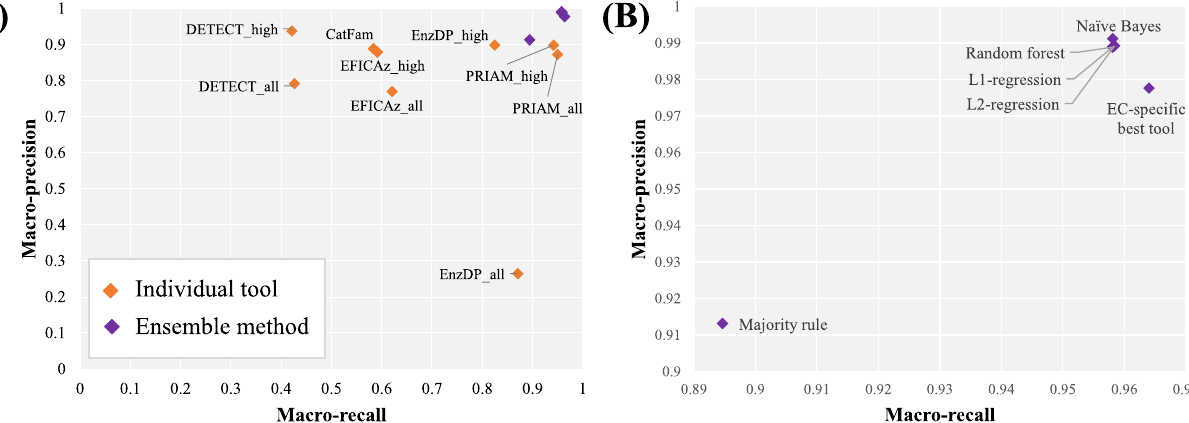
Fig 2. Performance of individual and ensemble enzyme annotation tools. (A) Precision/recall graph indicating performance of each method on the enzymatic test set from SwissProt, (B) focus on the improved performance of the ensemble methods. Our results show that combining predictions using almost any ensemble method gives better performance than using any individual